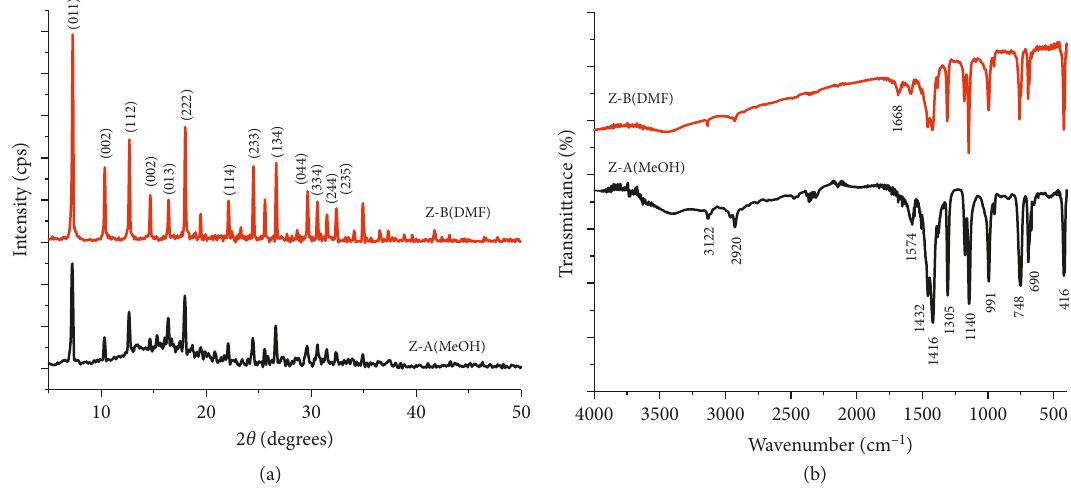
Figure 1: (a) XRD patterns and (b) FT-IR spectra of Z-A(MeOH) and Z-B(DMF) samples.